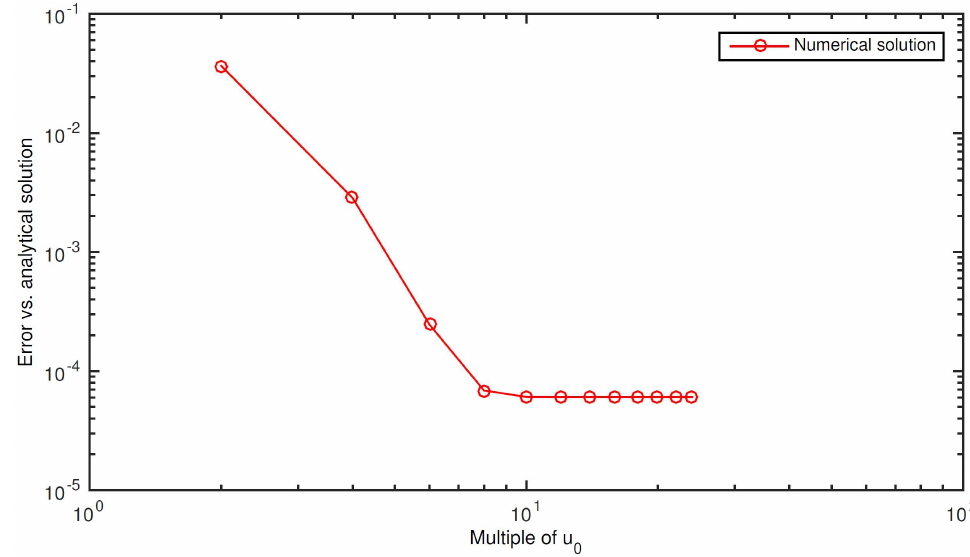
Figure 4. Convergence as K → ∞ . Here, the convergence is exponential. It appears that K of 10 already produces errors of order 10 − 4 in the ruin probability, and the choice of τ and h are the determining factors for producing the required accuracy.